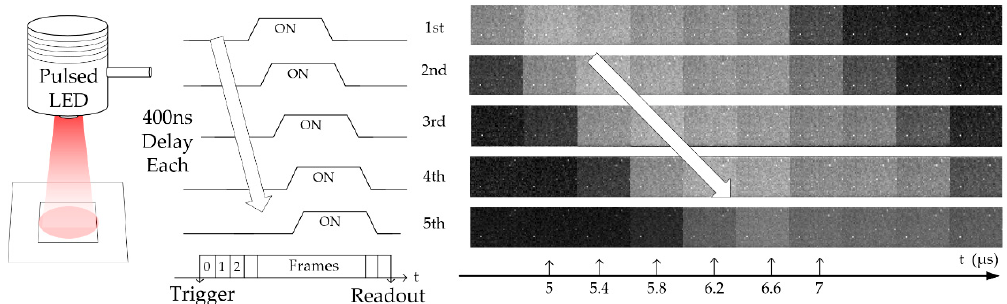
Figure 13. Pulsed light measurement at 5 Mfps. Each light pulse is triggered with a fixed delay of 400 ns following the previous one. The same delay can be confirmed from the sensor measurement.